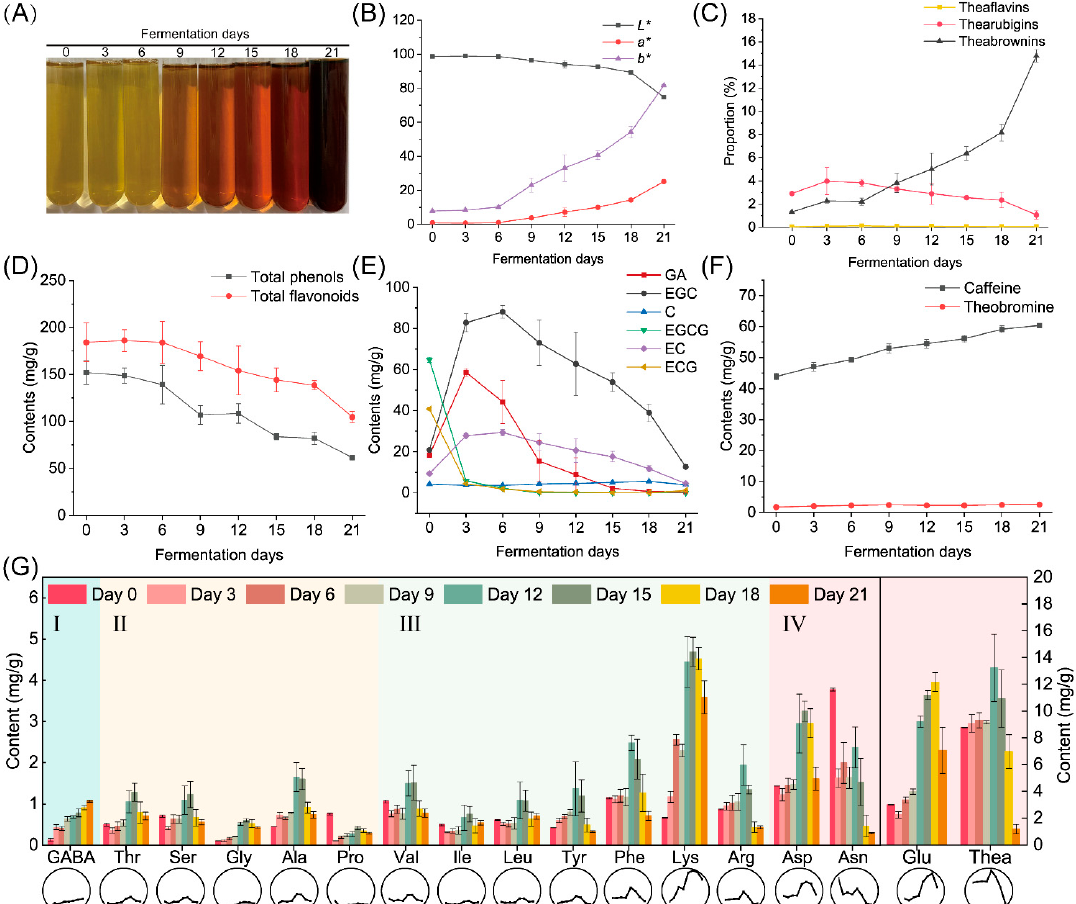
Figure 3. Physicochemical composition changes in samples fermented by Aspergillus niger PW-2. ( A ) Tea infusions. ( B ) Color difference among tea infusions. ( C ) Proportion of tea pigments including theaflavins, thearubigins and theabrownins. ( D ) Contents of total phenols and total flavonoids. ( E ) Contents of GA and catechins. ( F ) Contents of caffeine and theobromine. ( G ) Contents of flavor free amino acids (( Ⅰ) astringency; ( Ⅱ) sweetness; ( Ⅲ) bitterness; ( Ⅳ) umami), where the line chart on the bottom displays the trend visually. GA, gallic acid; GABA, γ -aminobutyric acid; Thr, threonine; Ser, serine; Gly, glycine; Ala, alanine; Pro, proline; Val, valine; Ile, isoleucine; Leu, leucine; Tyr, tyrosine; Phe, phenylalanine; Lys, lysine; Arg, arginine; Asp, aspartate; Asn, asparagine; Glu, glutamate; Thea,